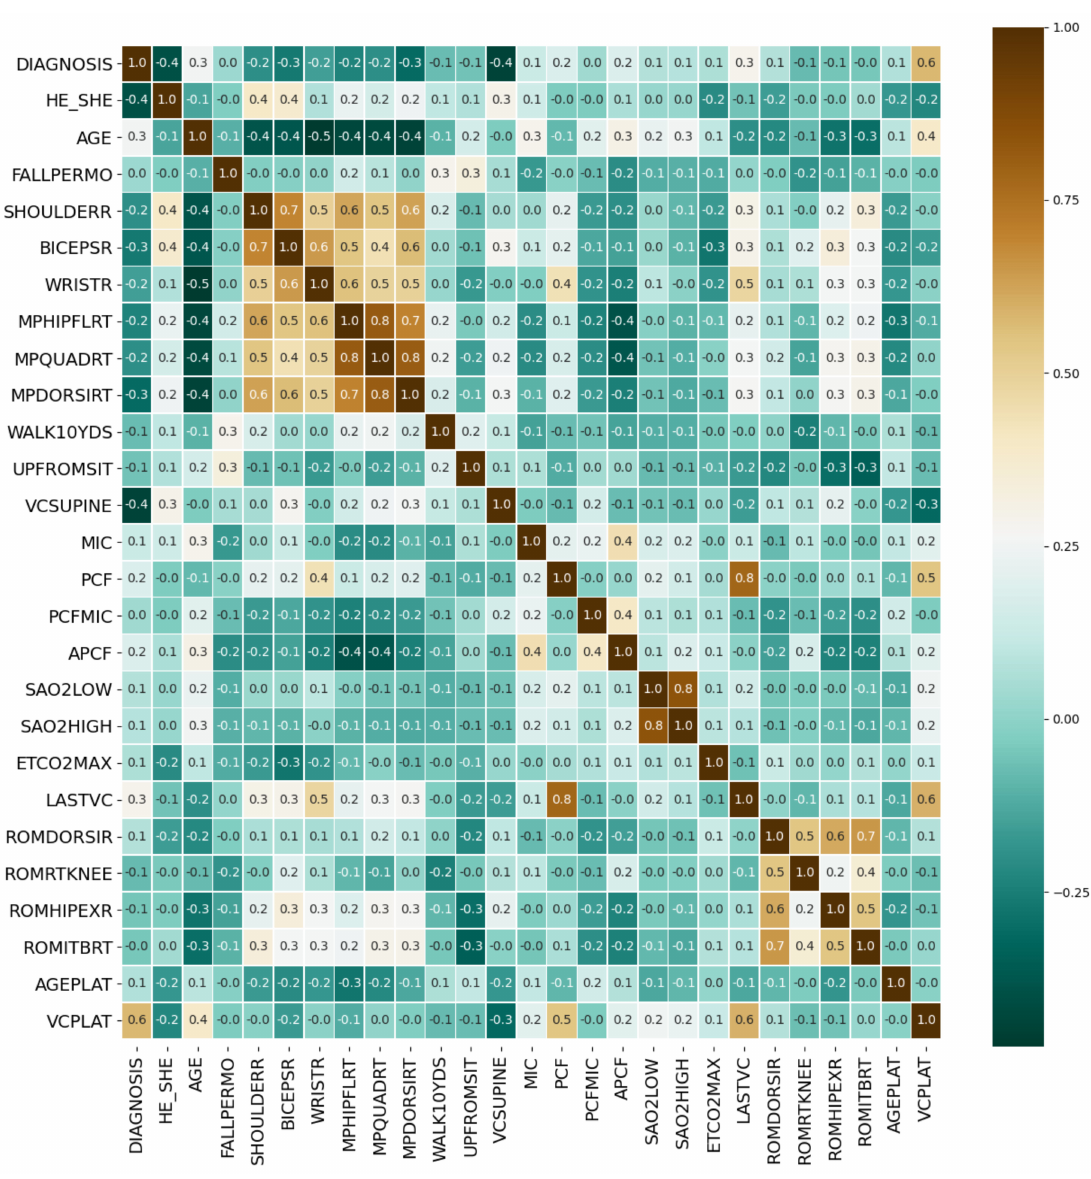
Figure 10. Optimized VCPLAT correlation coefficient matrix heat map. The horizontal and vertical axes represent medical features, and the numbers in the small squares represent the Spearman correlation coefficients between the two features. Color represents the degree of correlation. The larger the correlation coefficient, the darker the color, which means that the two features are more